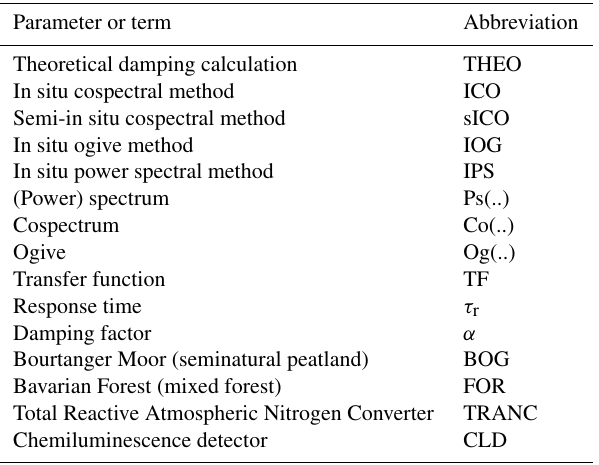
Table 2. Important terms and corresponding shortcuts used in this